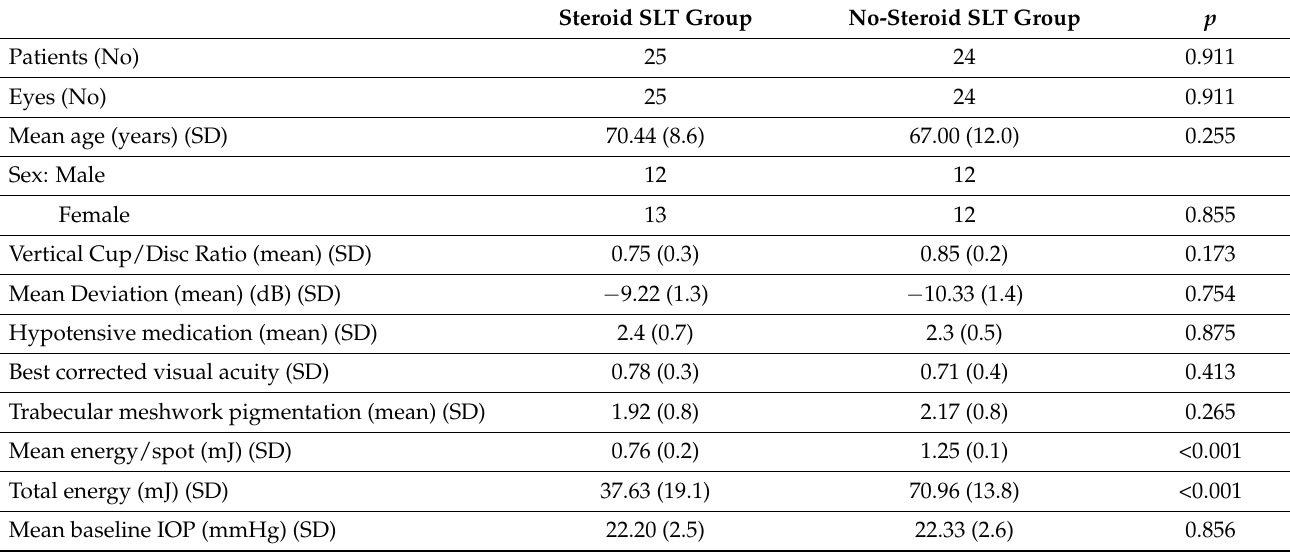
Table 1. Baseline characteristics—all